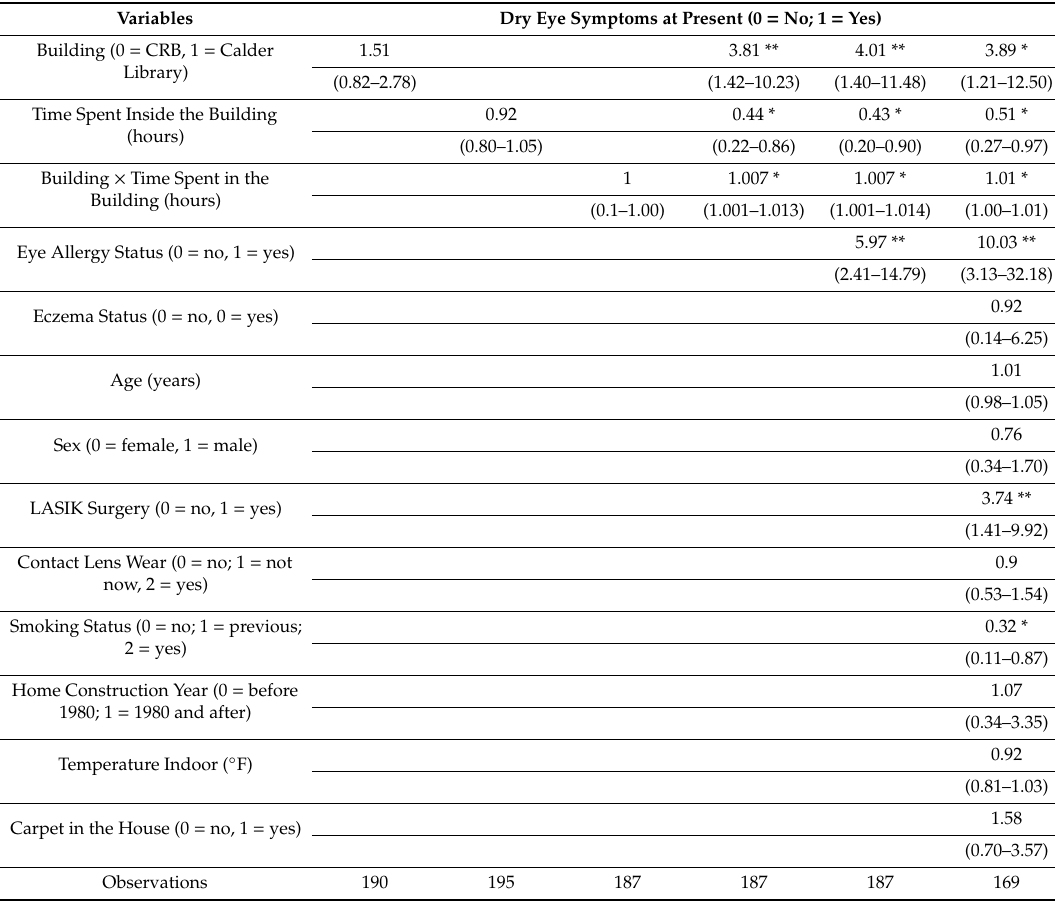
Table 4. Multivariable analyses of variables associated with the presence of DE symptoms at the time of